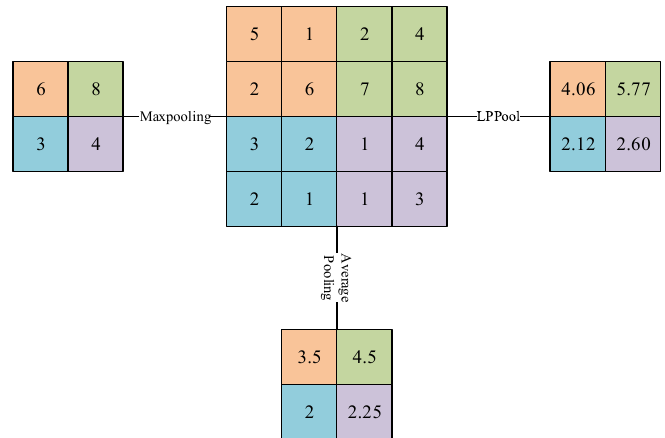
Figure 1. Calculation results of different pooling methods.